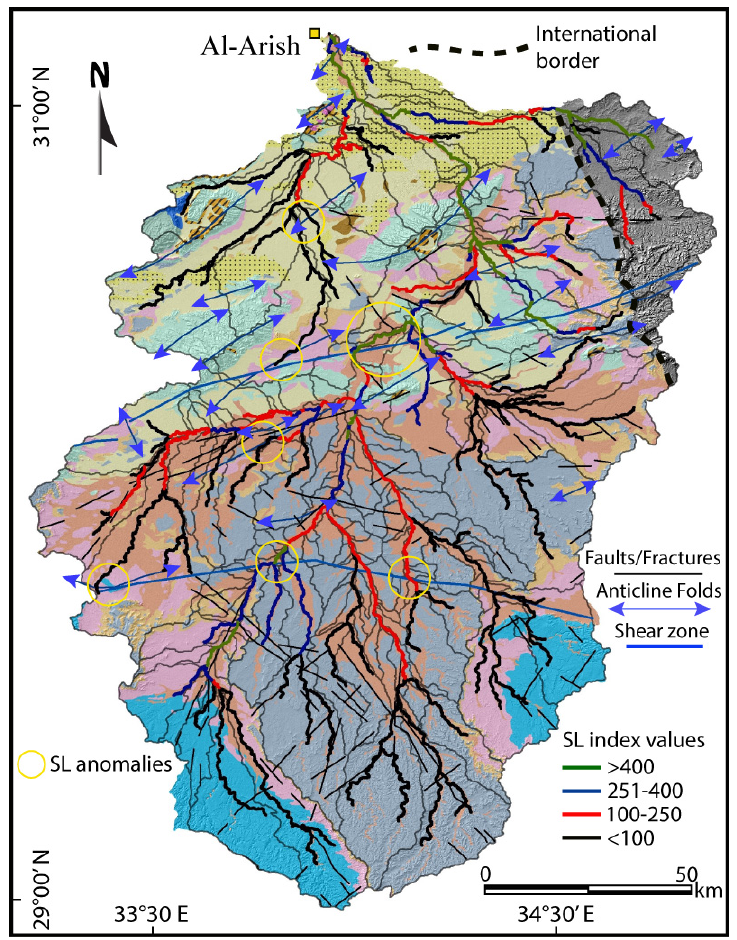
Figure 6. SL index along the drainage network of the study area. For lithological legend and catchments number, see Figures 3 and 5, respectively.